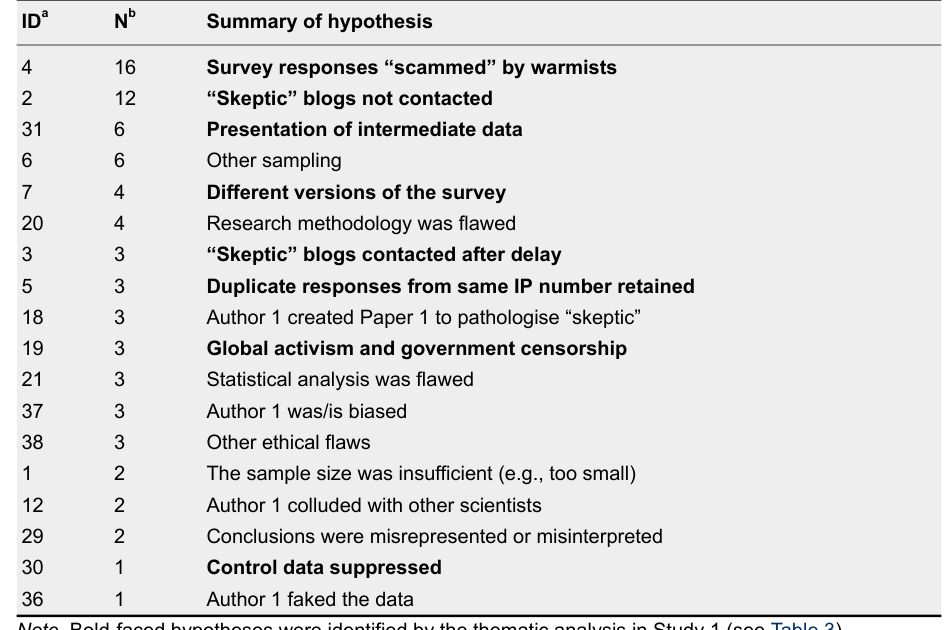
Frequency of Classification of Comments From Study 1 (“Depth” Search) by Participants in Study